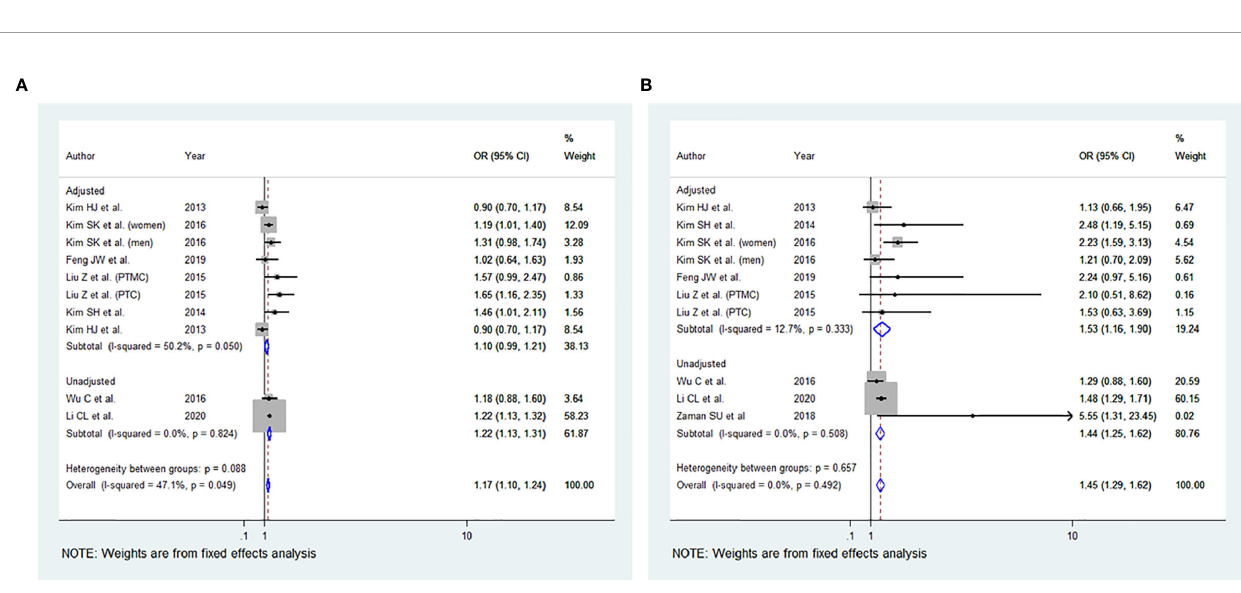
FIGURE 5 | Forest plots for the meta-analysis for the association between Body Mass Index and Multifocality. (A) Meta-analysis between overweight and multifocality. (B) Meta-analysis between obesity and